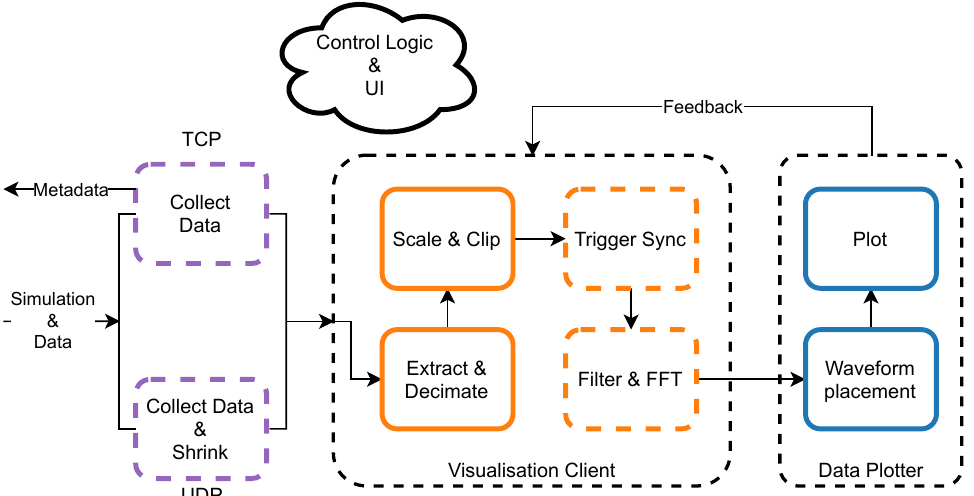
Figure 11. Visualisation data processing pipeline. In most cases, there is no need to plot data from all 512 channels. Therefore, only channels that can be presently visible are processed by subsequent